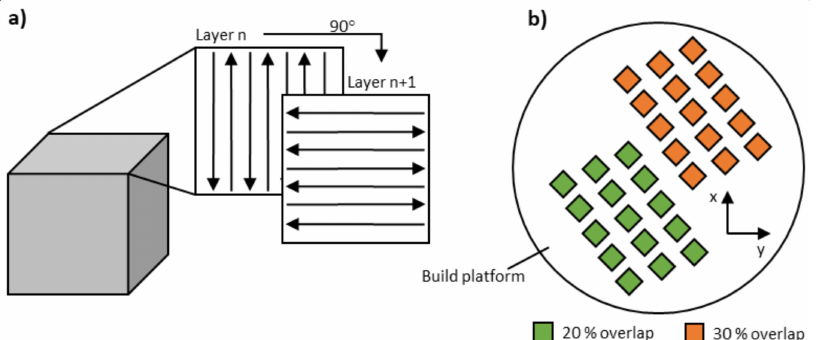
Figure 2. ( a ) A 3D model of the cuboid specimen with an illustration of the applied scan strategy. ( b ) Specimen arrangement on the build platform (top